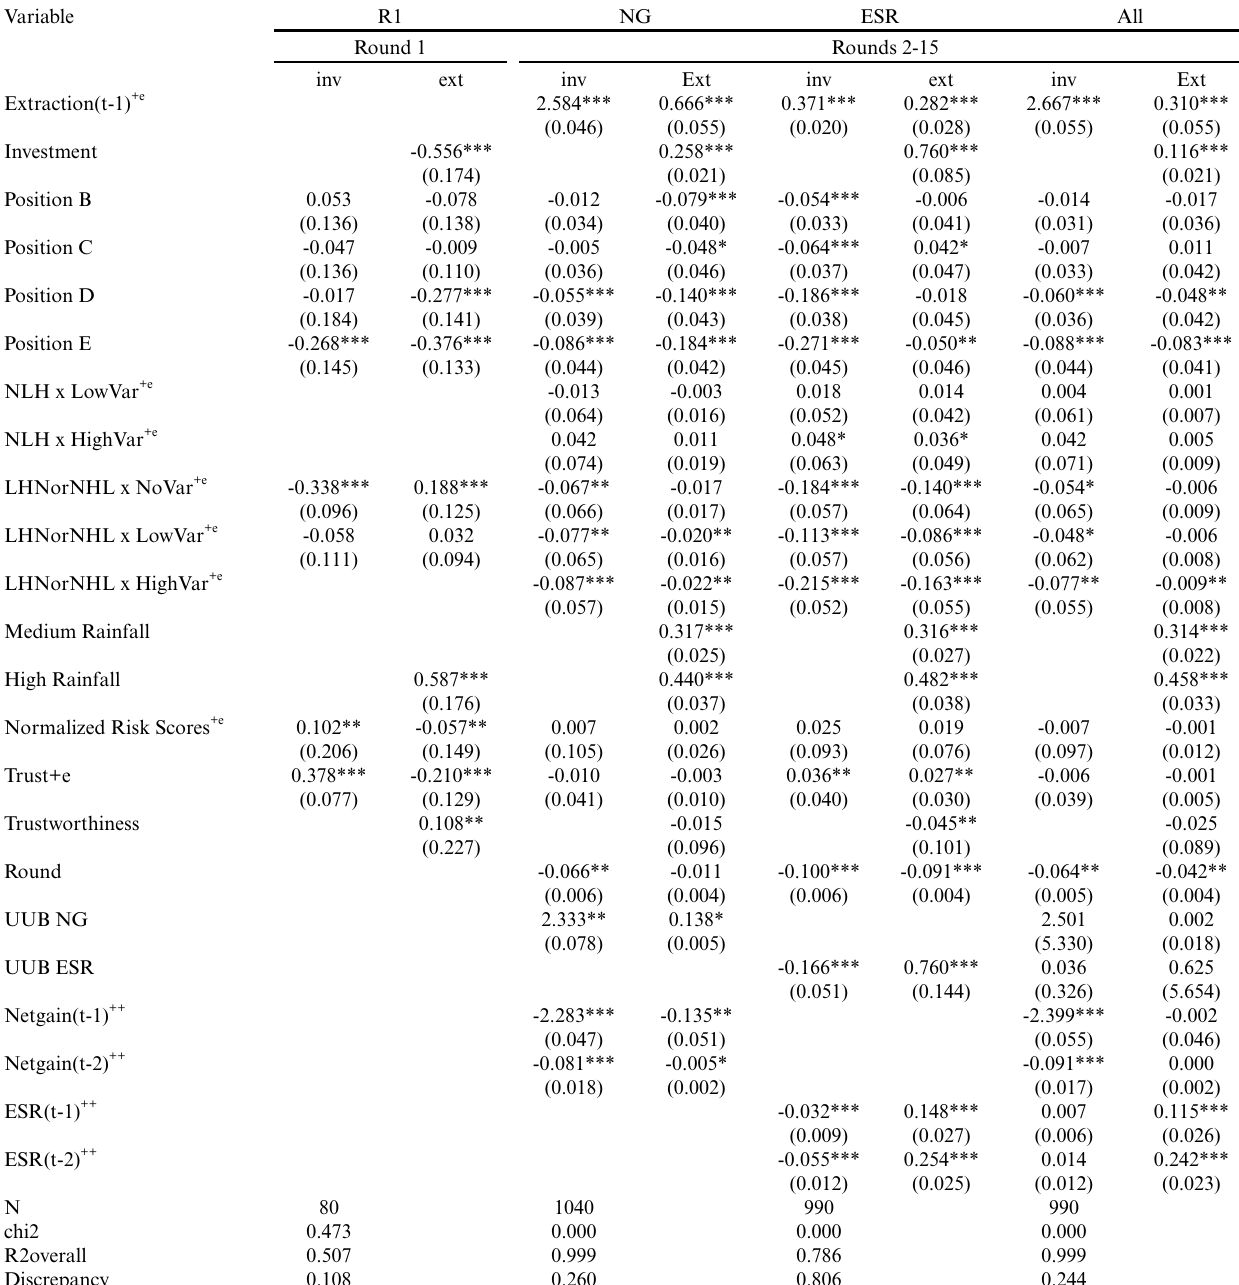
Table 7 . Results for the model reported in equation 5 at the individual level. Coefficients represent the total effect of variables of interest (direct and indirect